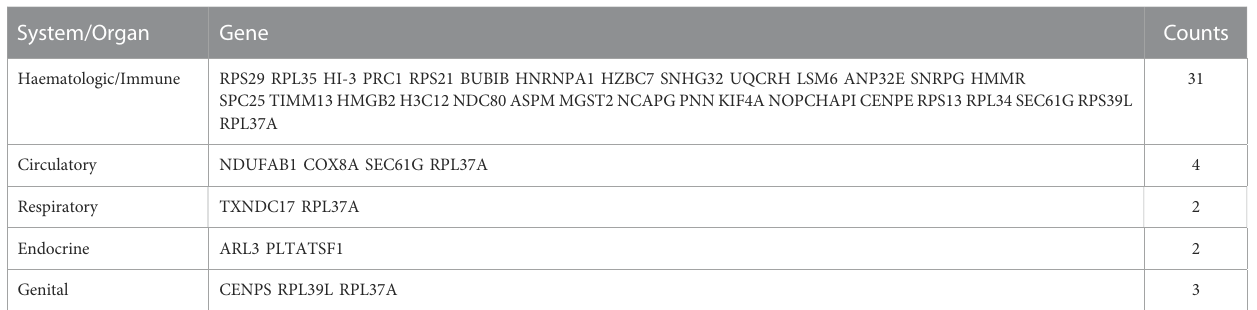
TABLE 1 Distribution of tissue/organ-speci fi c expressed genes identi fi ed by BioGPS.